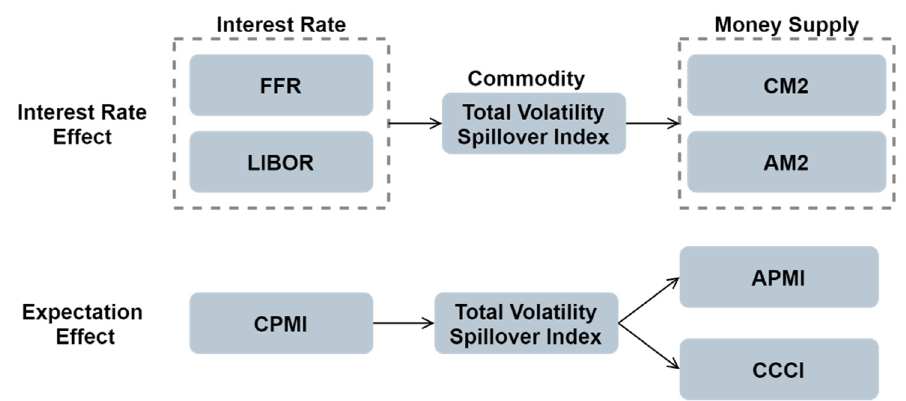
Figure 7. The risk contagion mechanism.